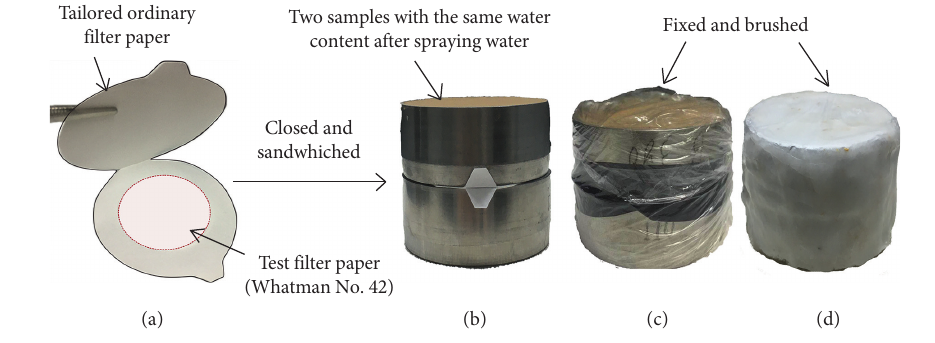
Figure 4: Process of wrapping specimens.